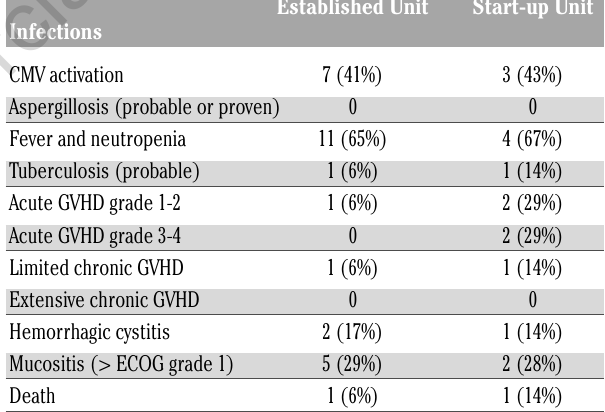
Table 3. Summary of adverse events.